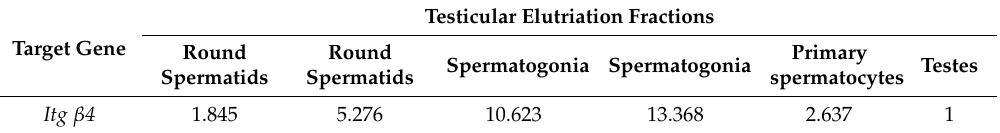
Table 1. Gene expression of β 4 integrin in the cell-type fractions. Cq value of the gene is normalized by reference gene Rps2 . Numbers > 1 are considered as strongly expressed in the individual cell-types.